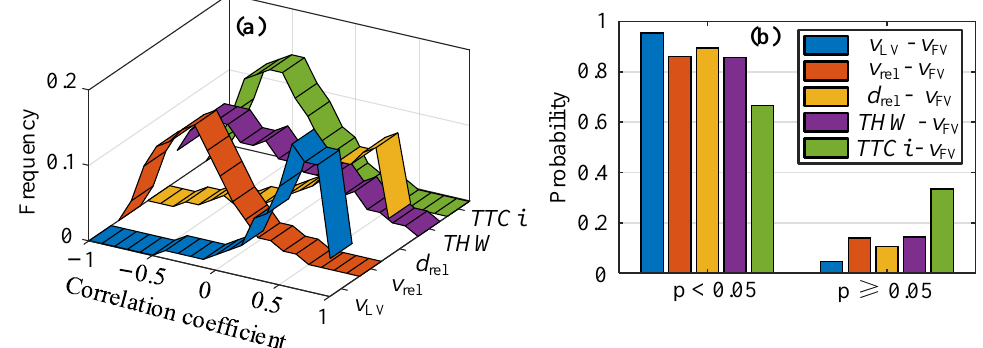
Figure 2. Distribution of correlation between parameters and following vehicle speed, where ( a ) shows the probability distribution of the maximum correlation coefficient, and ( b ) shows the p -values of the significance test.